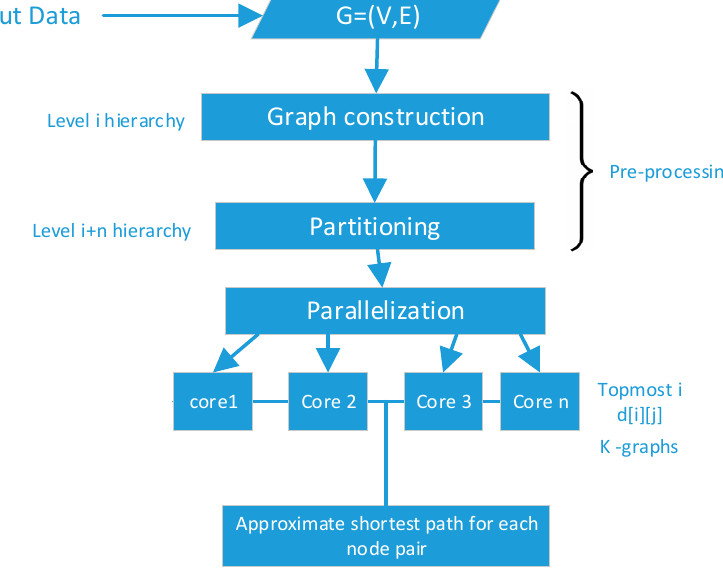
Figure 4. Architecture of the algorithm for computing shortest path.